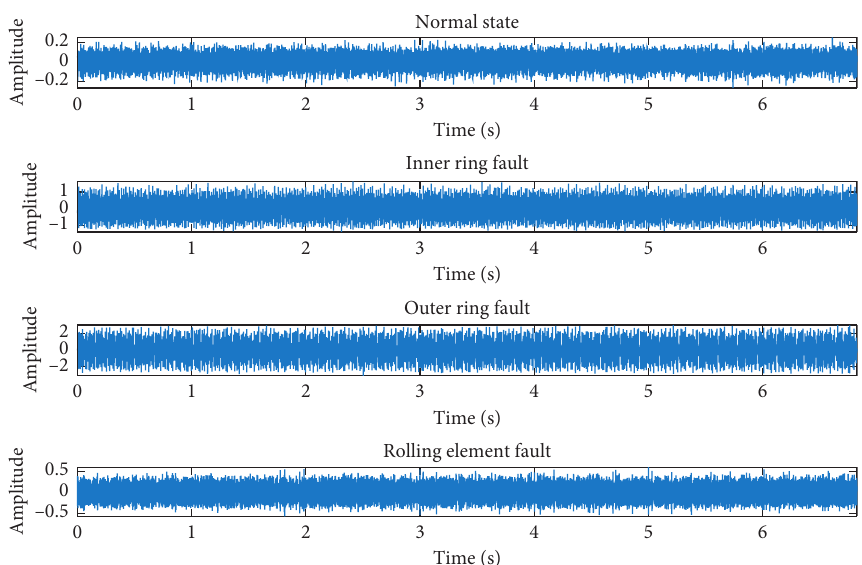
Figure 5: The time-domain diagram of four states of rolling